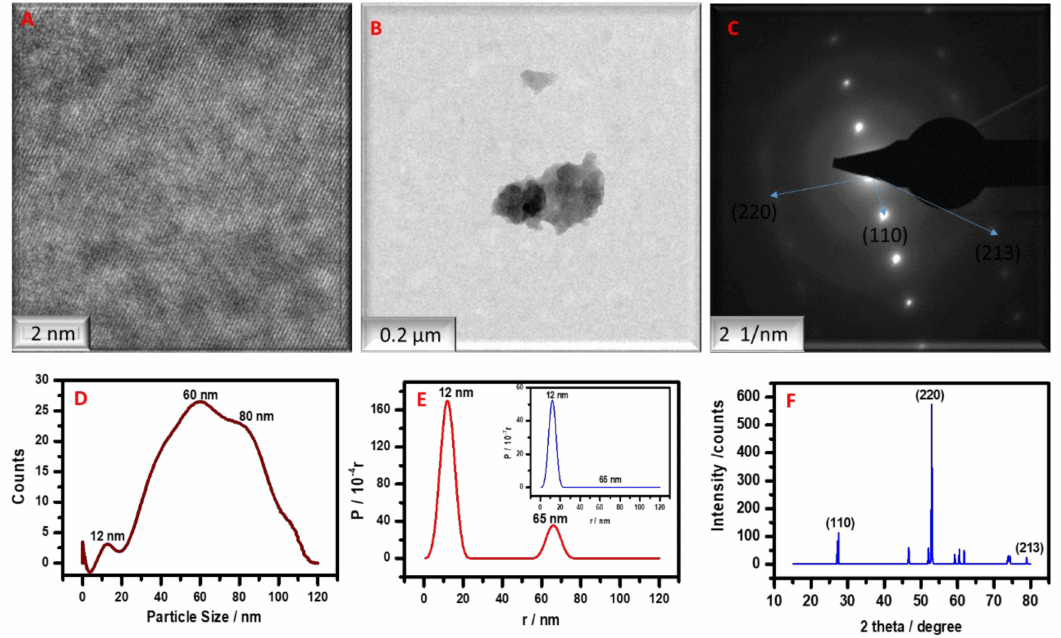
Figure 3. HRSEM ( A , B ) and SAED ( C ) images of G1PPT-co-P3HT, SAXS PDDF ( D ), size distribution function by volume and by number(inset) ( E ) and XRD pattern ( F ) of G1PPT-co-P3HT [1].